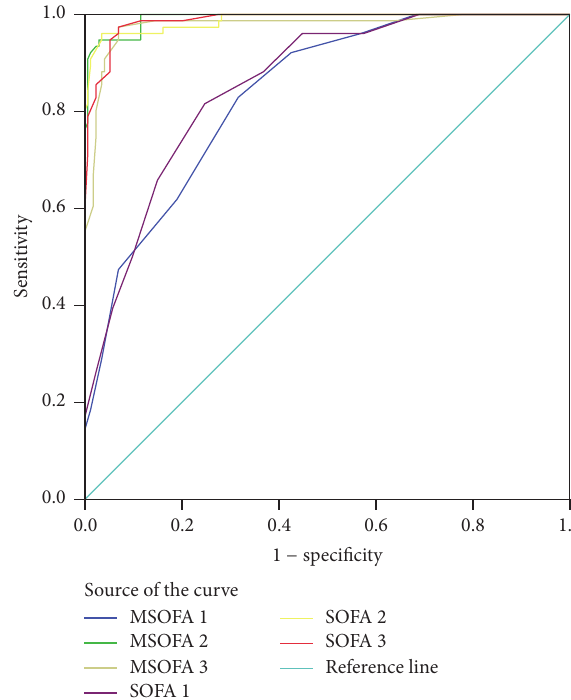
Figure 1: Comparing the predictive power SOFA 1, SOFA 2, and SOFA 3 and MSOFA 1, MSOFA 2, and MSOFA 3, in predicting mortality using ROC